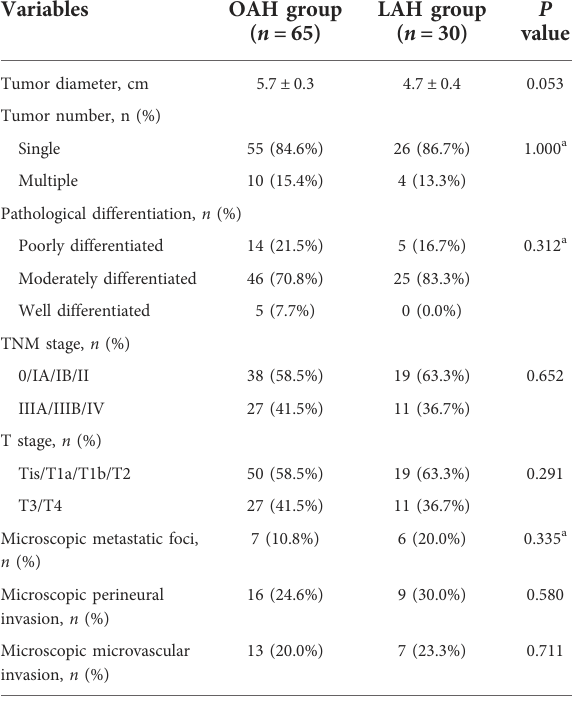
TABLE 2 Comparison of the pathologic fi ndings between OAH and LAH